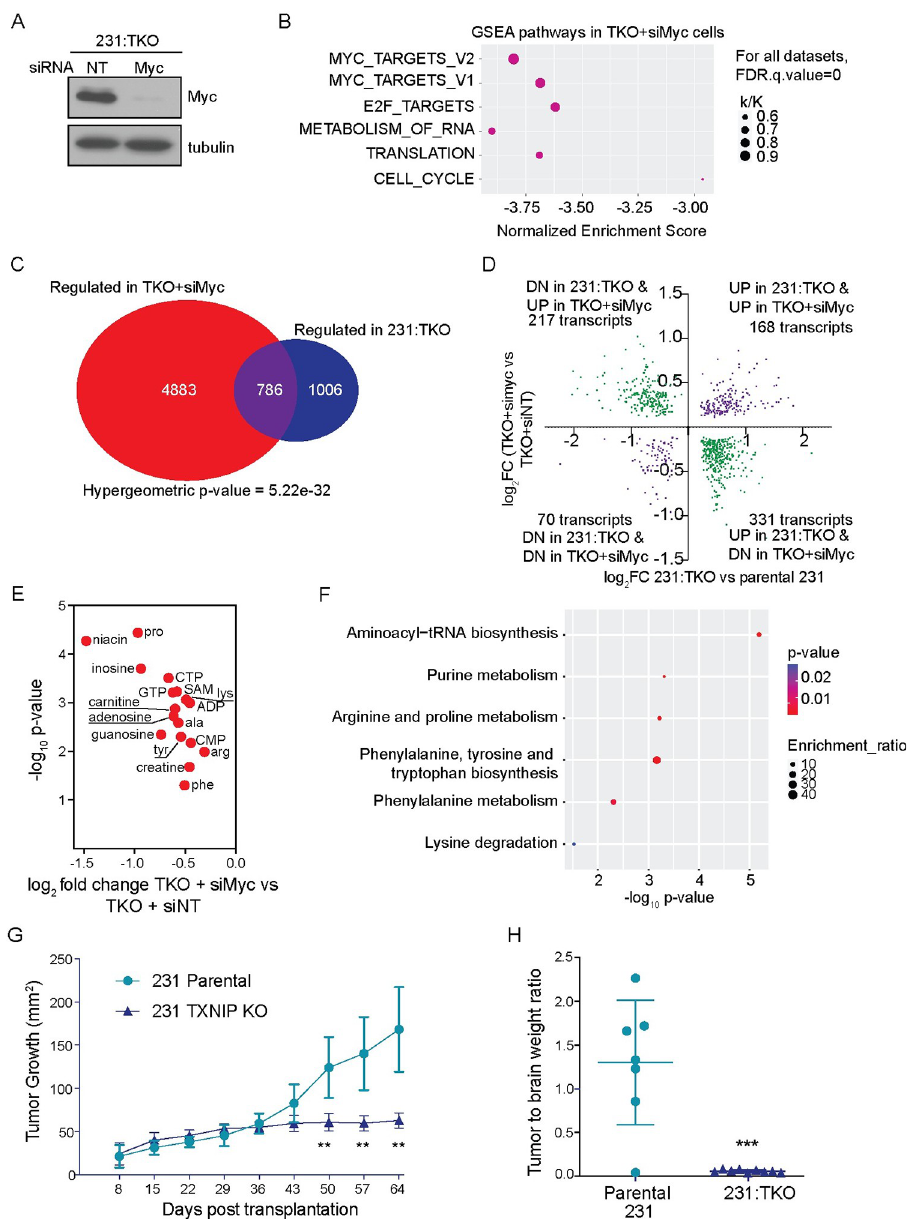
Fig 2. Gene expression changes in TKO are Myc dependent. ( A ) Western blotting was used to determine c-Myc and tubulin levels in 231:TKO cells following siRNA-mediated Myc knockdown. siRNA non-targeting control: siNT or siRNA targeting Myc: siMyc. ( B ) RNA sequencing was performed on 3 biological replicates 231:TKO with siNT or 231:TKO cells with siMyc to identify Myc-dependent genes in 231:TKO cells. Preranked GSEA was performed to identify pathways for Myc-dependent genes by comparing a ranked list of up- and down-regulated genes in 231:TKO +siMyc cells with the Hallmark and Reactome datasets in the MSigDB. The enriched GSEA pathways of Myc- dependent genes in 231:TKO cells were plotted using ggplot2 package from R studio. The k/K value is a ratio of number of genes in our data set (k) divided by the number of genes in the indicated datasets (K). ( C ) All regulated genes with adjusted p -value < 0.05 in 231:TKO were compared with all regulated genes with adjusted p -value < 0.05 in 231:TKO+siMyc dataset to identify genes regulated in both datasets. The Venn diagram was drawn using a VennDiagram package in R studio. ( D ) The 786 Myc-dependent transcripts were subdivided into 4 categories based the direction of their regulation in the 231:TKO and 231:TKO+siMyc datasets. ( E ) Seventeen metabolites that were up- regulated in 231:TKO cells also showed down-regulation with Myc knockdown in TKO cells. ( F ) Pathway analysis was performed using MetaboAnalyst to identify the metabolic pathways that were reciprocally regulated by Myc and TXNIP. The enriched metabolic pathways were plotted using ggplot2 package from R studio. ( G ) Parental 231 and 231: